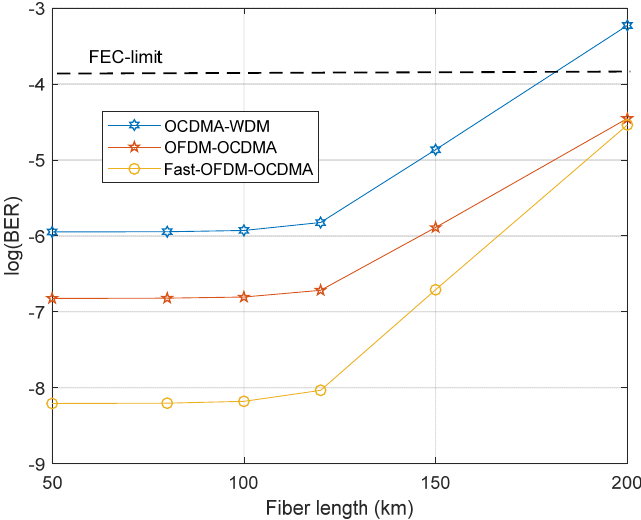
Figure 4. BER versus fiber length.